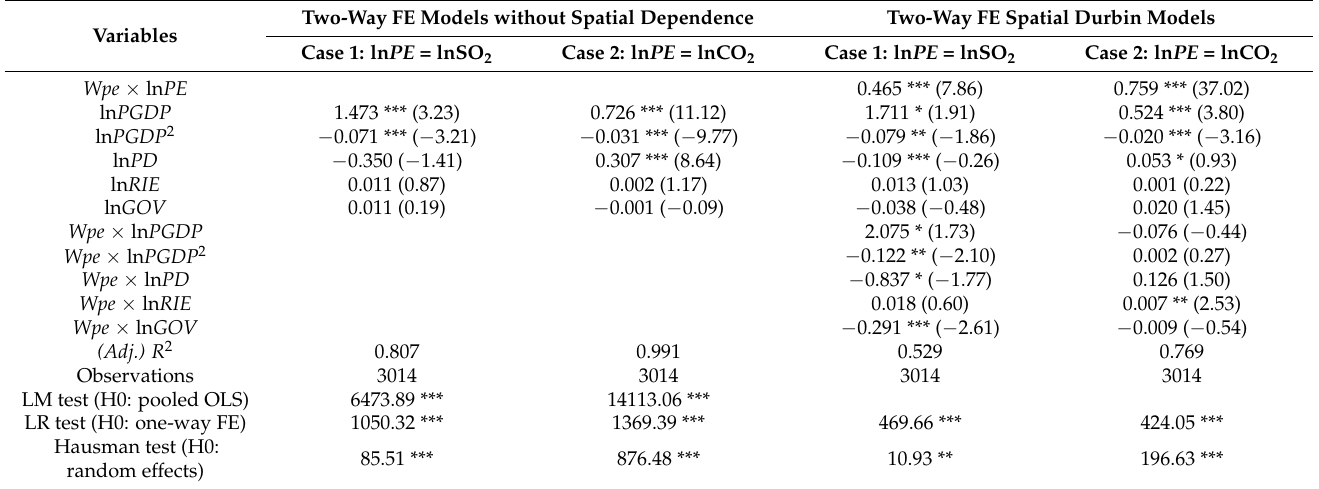
Table 4. Estimation results of two-way FE models without and with identifying spatial